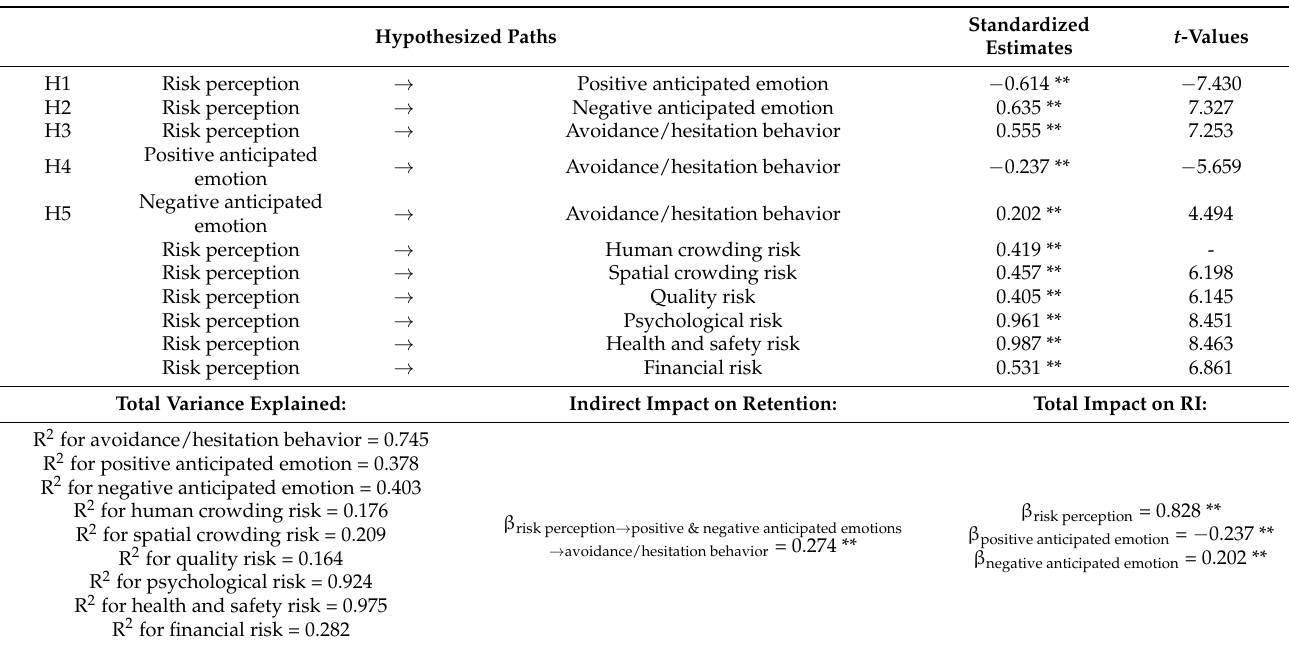
Table 2. Structural equation modeling results and hypothesis testing ( n = 429).